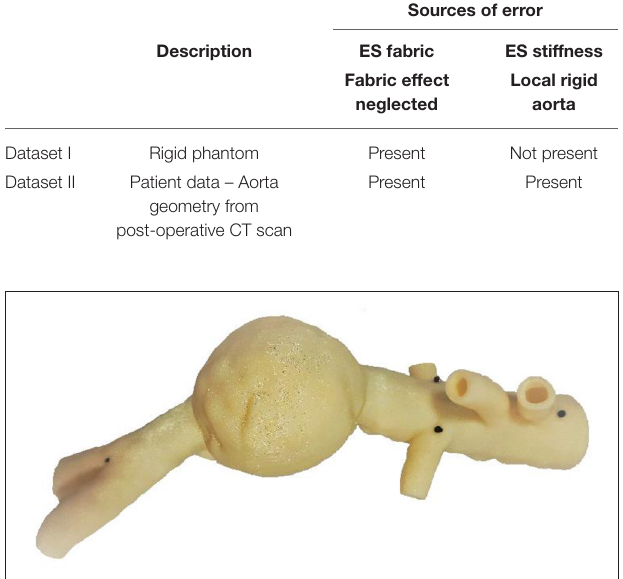
TABLE 2 | Information about EVAR patients used for the validation of our